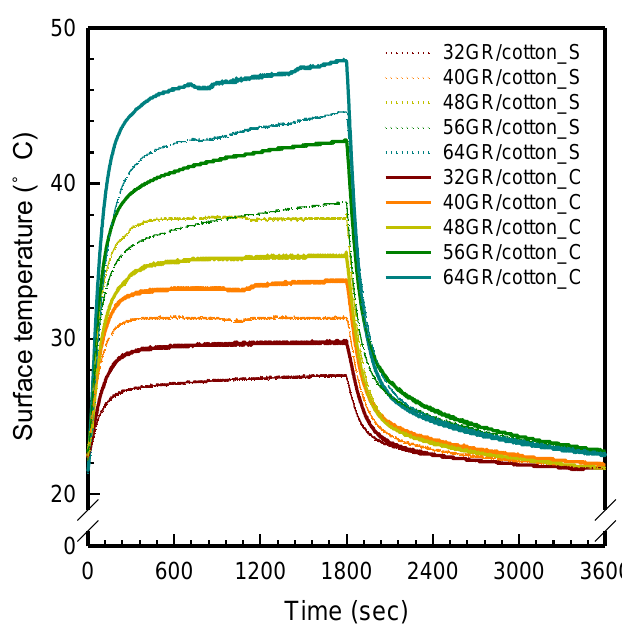
Figure 8. Time-dependent temperature of local area of GR / cotton coated with various high-content of graphene nanoplatelets at 5 V (Dot line: curved-shape (C) and Solid line: straight-shape (S)).